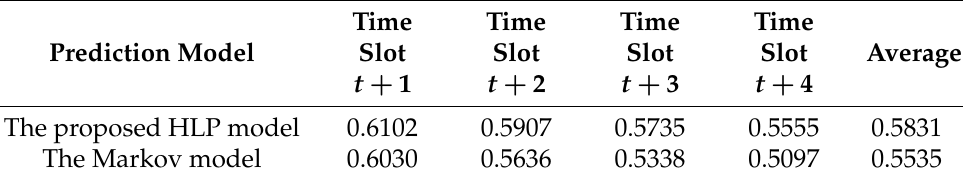
Table 4. Top-1 accuracy from the prediction